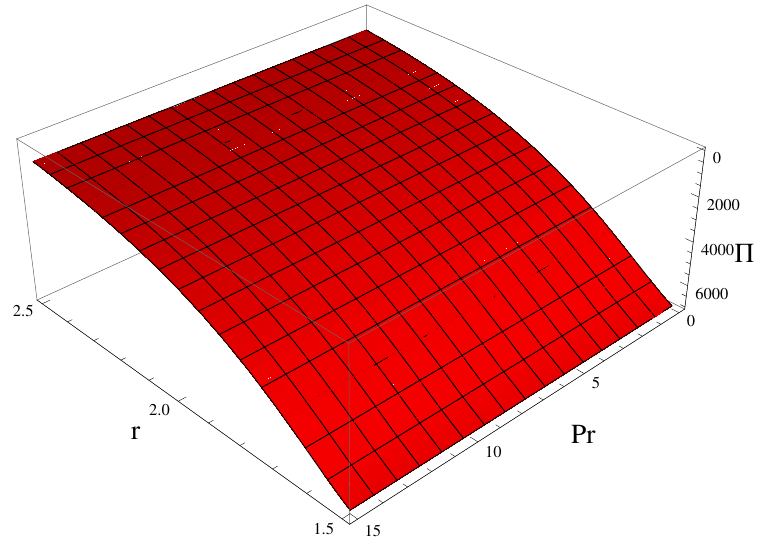
Figure 2. Anisotropic factor ( Π ) of a self-gravitating object via schematic diagrams for a suitable model parameter value α , such as α = 0.033. One can examine through this diagram that, as the value of r increases, the system enters into an anisotropic phase.